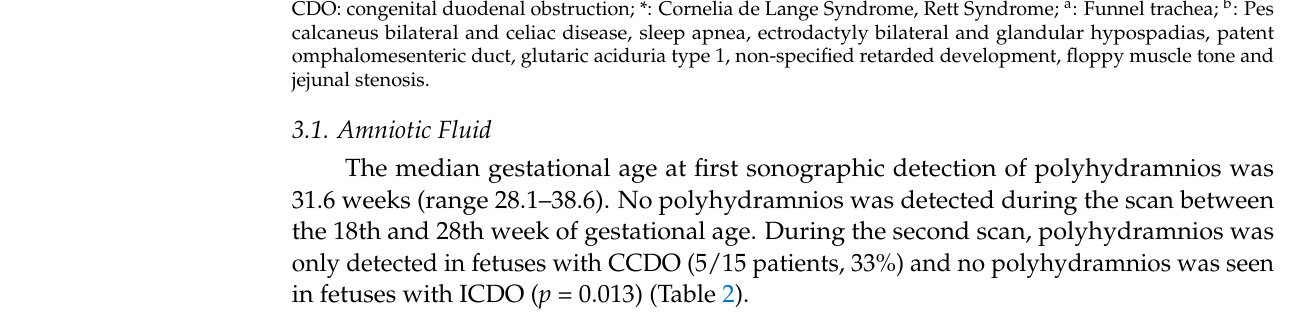
Table 2. Amniotic fluid assessment in fetuses with complete or incomplete duodenal obstruction